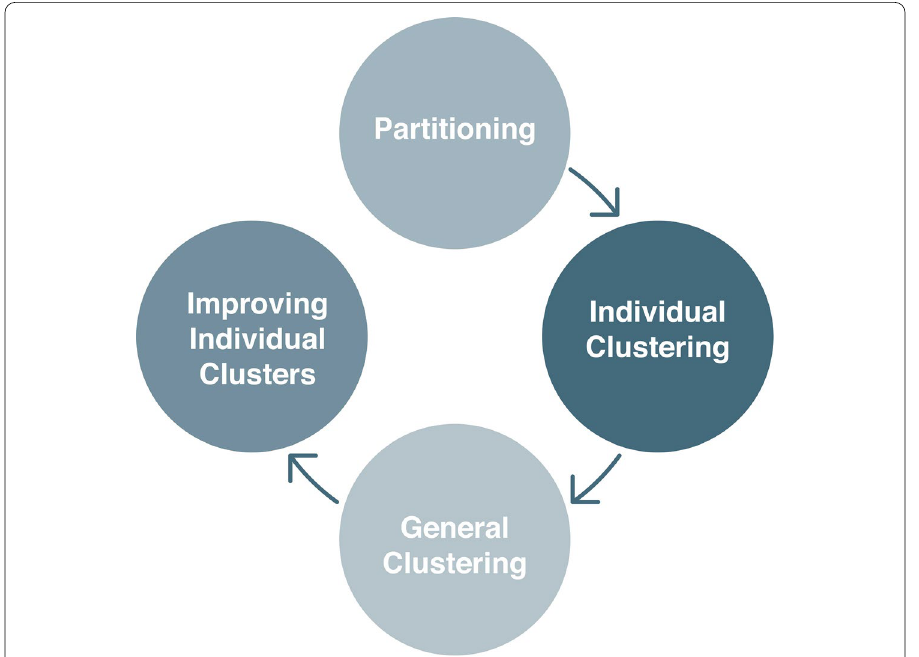
Fig. 3 General procedure of multi-machine clustering algorithms